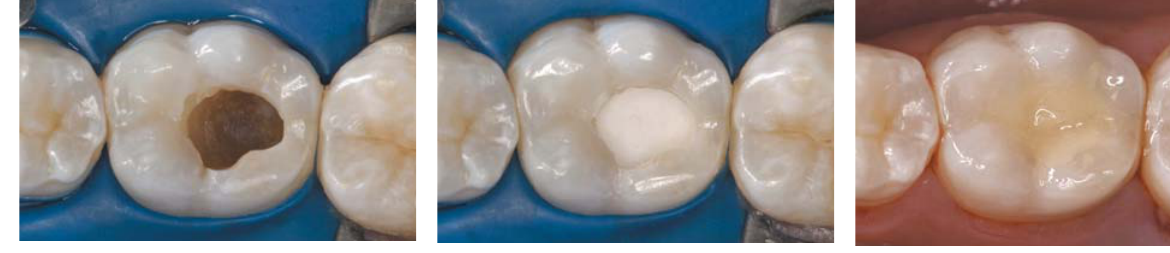
FIGURE 6- Temporary restoration with